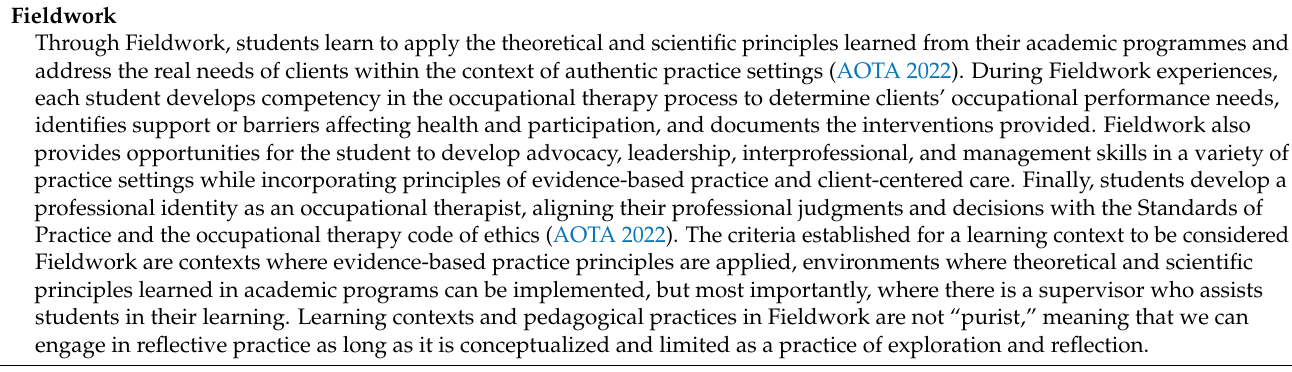
Table 2. Learning educational contexts and pedagogical practice